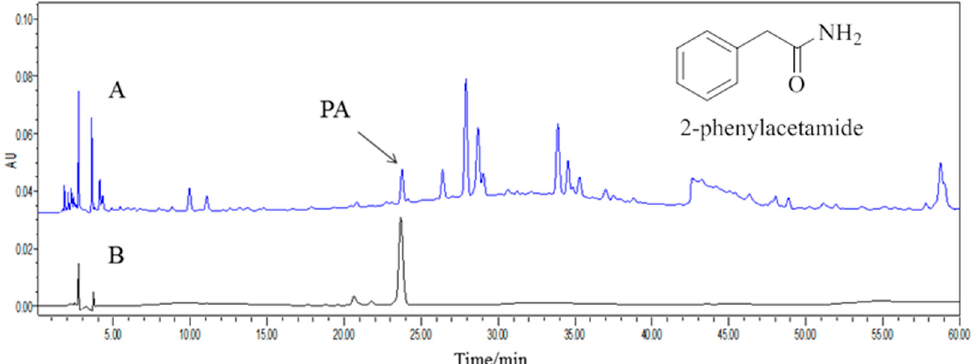
Figure 8. Representative HPLC chromatogram of PA ( A ) and crude water extract of LA ( B ). Waters Alliance 2695 separations module equipped with Empower software hyphened with quaternary pumps, an automatic injector, a Waters 2998 photodiode array (PDA) detector at 190 – 800 nm, and a 250 mm × 4.6 mm × 5 µ m Platisil ODS C18 column was used for the separation. HPLC analysis conditions: Acetic acid water ((A), 0.1%)-acetonitrile (B), 0~60 min (5~25% (A)); flow velocity: 1 mL/min, 5 µ L injection; wavelength of detection: 254 nm; column temperature: 30 ° C.